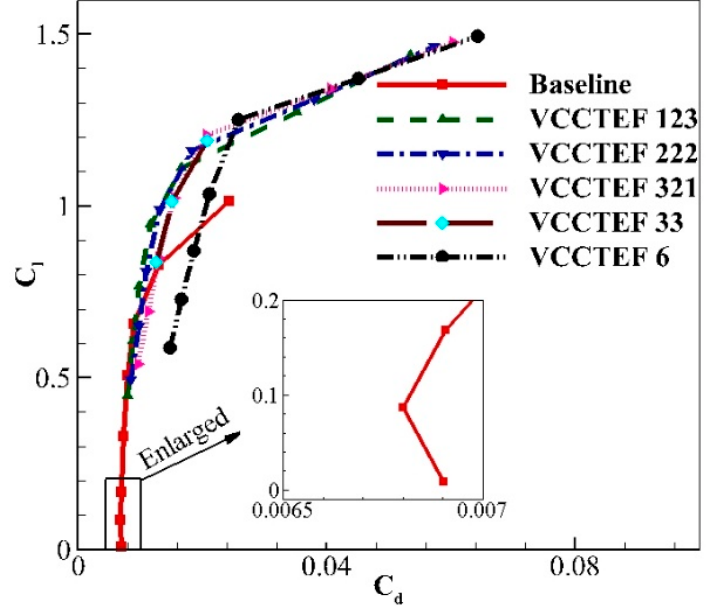
Figure 24. Comparison of computed drag polar of baseline airfoil with various VCCTEF configurations.